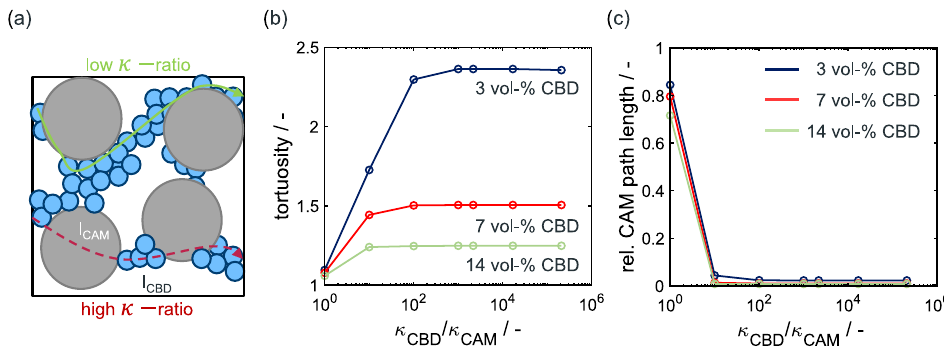
Figure 4. ( a ) Schematic depiction of current pathways in an electrode with low CBD content. Weighted geodesic tortuosity ( b ) and relative path length ( c ) in an electrode with 50 vol-% CAM and d 50 =